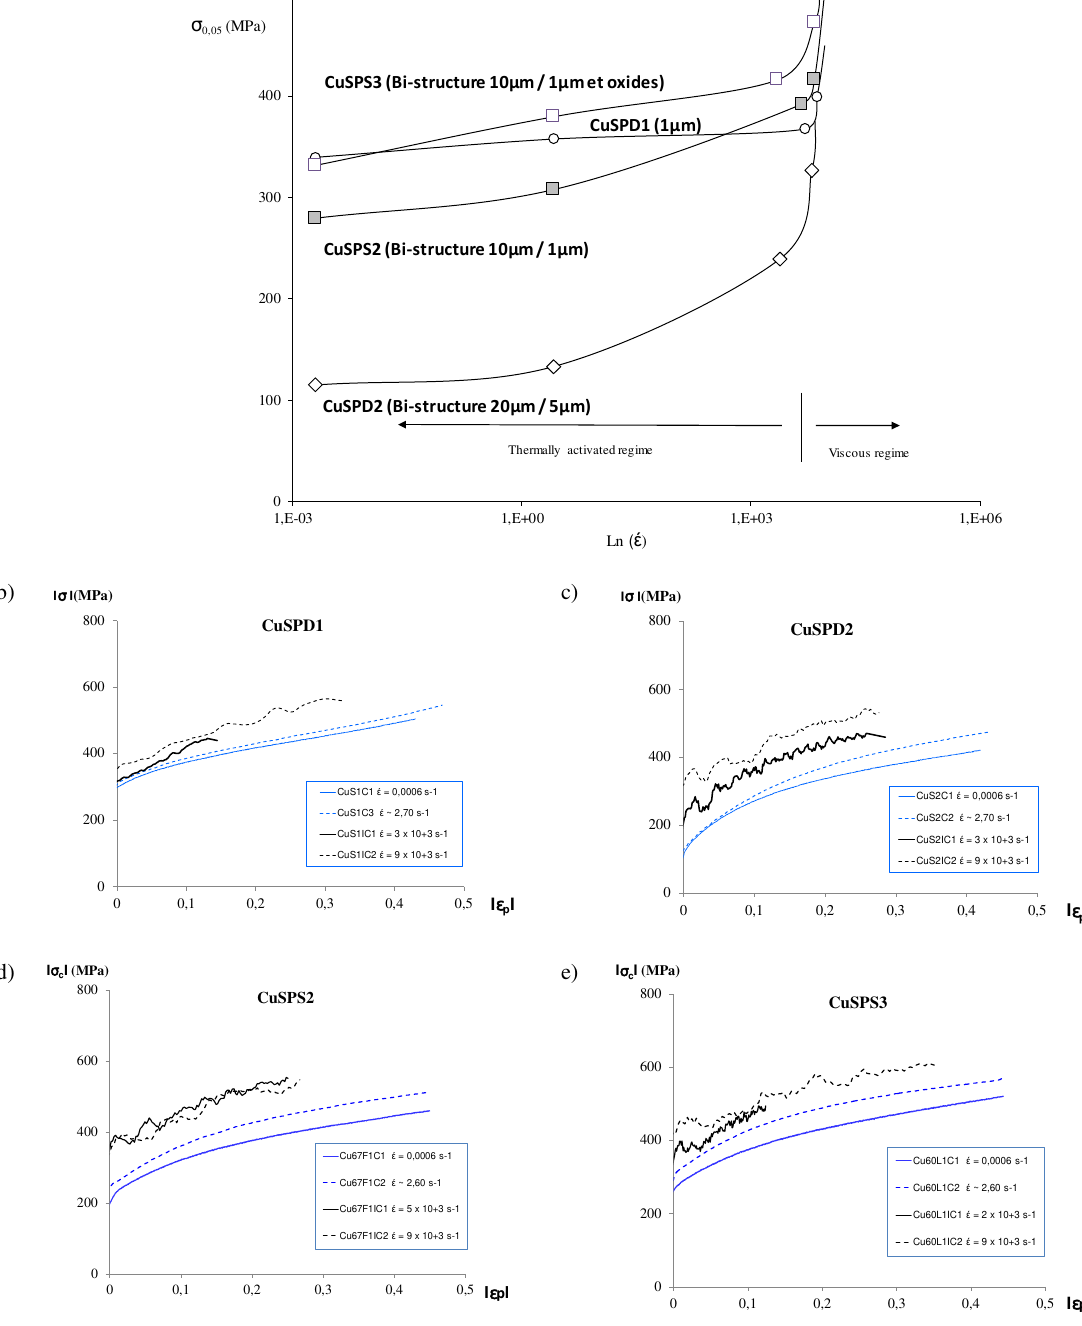
Fig. 8. Responses at function of strain rate a) at a strain of 0,05, b) and c) true strain true strain curves for SPD materials, d) and e) for SPS